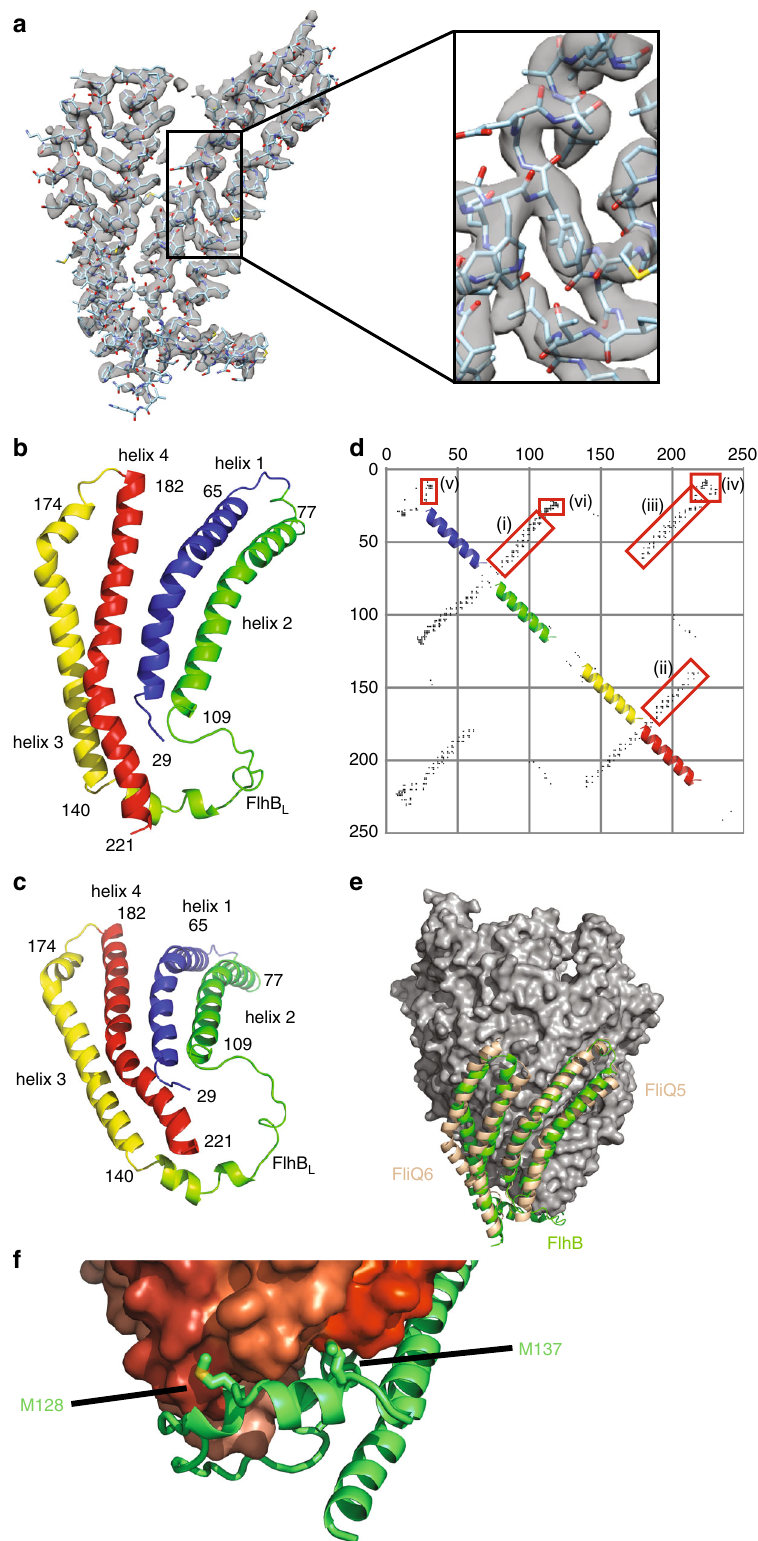
Fig. 3 Structural analysis of the FlhB hydrophobic domain. a Quality of the cryo-EM volume corresponding to FlhB. Zoom box shows the fi t to density of the model. b , c Rainbow colouring of the FlhB model with numbers indicating the N and C termini of the four helices. d Evolutionary co-variation within FlhB calculated using RaptorX 46 . Only contacts with a probability >0.5 are plotted. Red boxes highlight the interaction between helix 1 and 2 (i), helix 1 and 4 (ii), helix 3 and 4 (iii), the N terminus and FlhB CN (iv), within the N terminus (v) and between FlhB L and the N terminus (vi). e Overlay of FlhB (green) and a modelled FliQ 5 and FliQ 6 following the same helical parameters as FliQ 1 to FliQ 4 in V. mimicus . f Zoomed view of the interaction between the FlhB loop and FliQ, highlighting the intercalation of conserved hydrophobic residues in FlhB between the FliQ